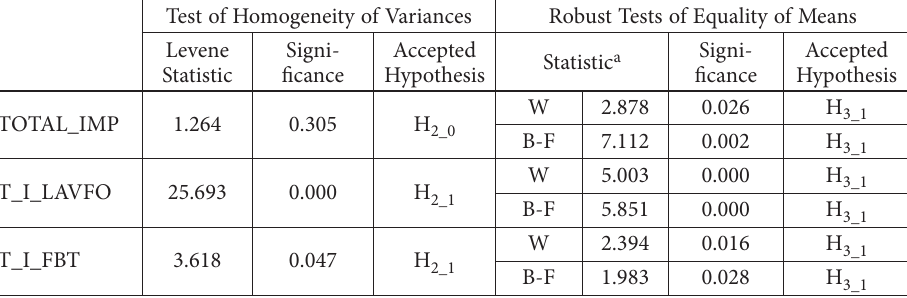
Table 4. The results of testing the statistical significance of Romania’s import volumes average values in the year 2016, at EU states group level (source: authors’ own computations) Test of Homogeneity of Variances Robust Tests of Equality of Means Levene Signi- Accepted Signi- Accepted Statistic a Statistic ficance Hypothesis ficance Hypothesis 2.878 TOTAL_IMP 1.264 0.305